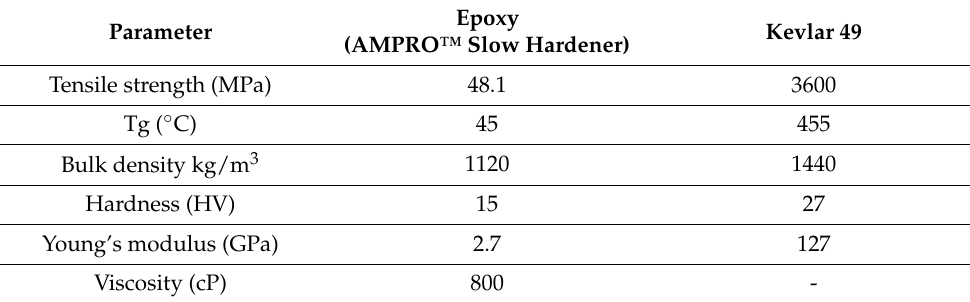
Table 3. Physical and chemical properties of epoxy and Kevlar fiber. Parameter